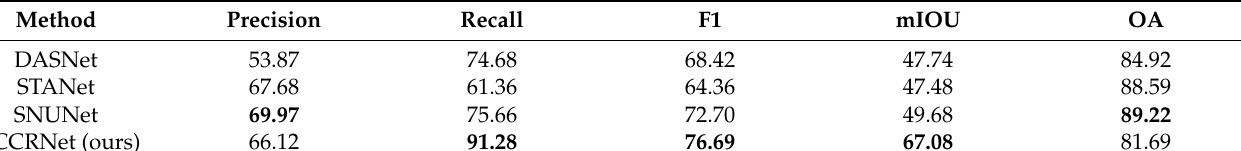
Table 9. Comparison of results on DSIFN dataset. The bold numbers indicate the best results.